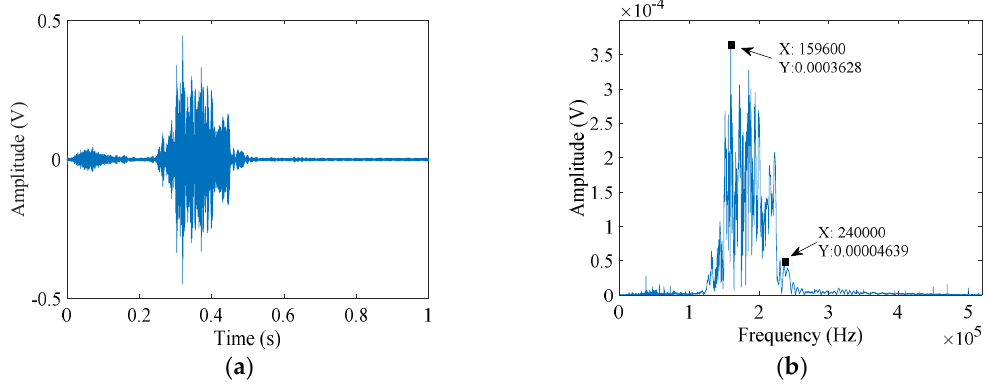
Figure 5. The received sweep signals. ( a ) time-domain; ( b ) frequency-domain.